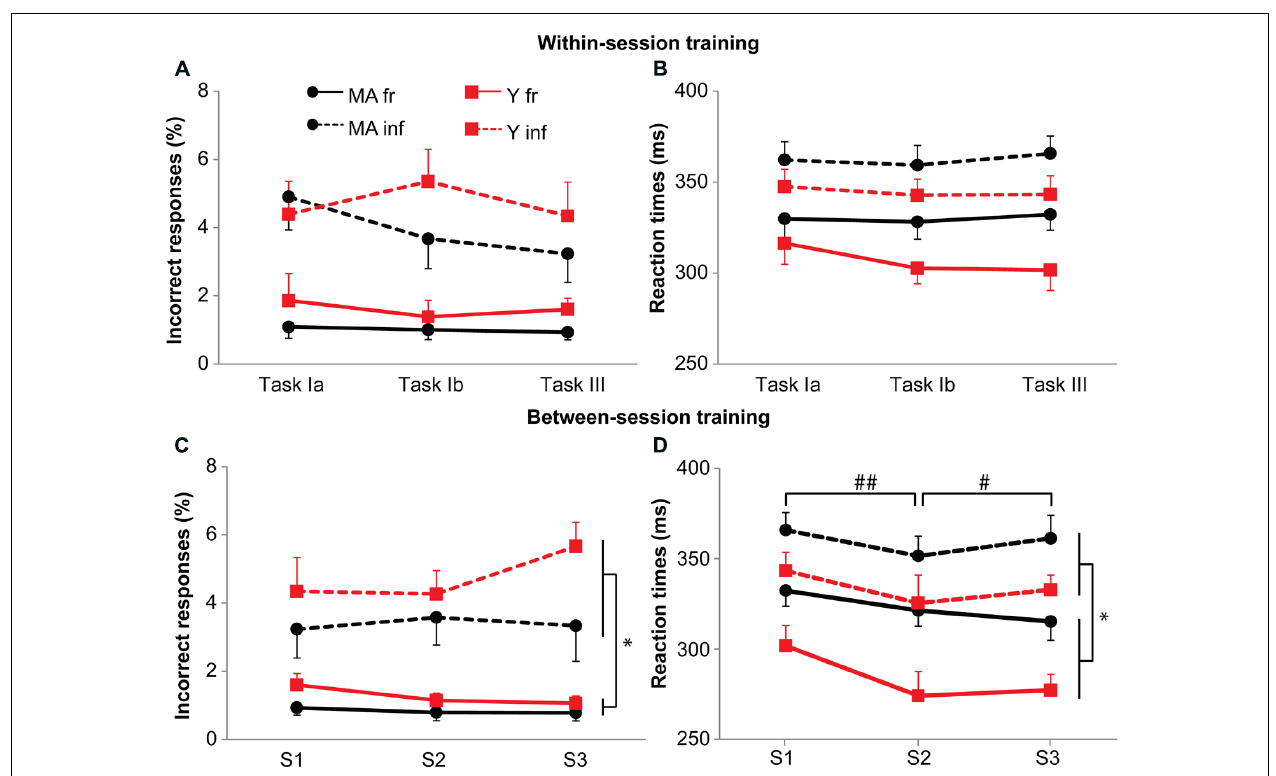
(C,D) Between-session practice effects. Data represent first six blocks of CRT task on task III. Error bars represent SE. * shows main effects, ## shows main between session effects for frequent and infrequent stimuli, # shows between sessions effect for frequent stimuli only. Please note for the young subjects, the learning curve on reaction times for the frequent